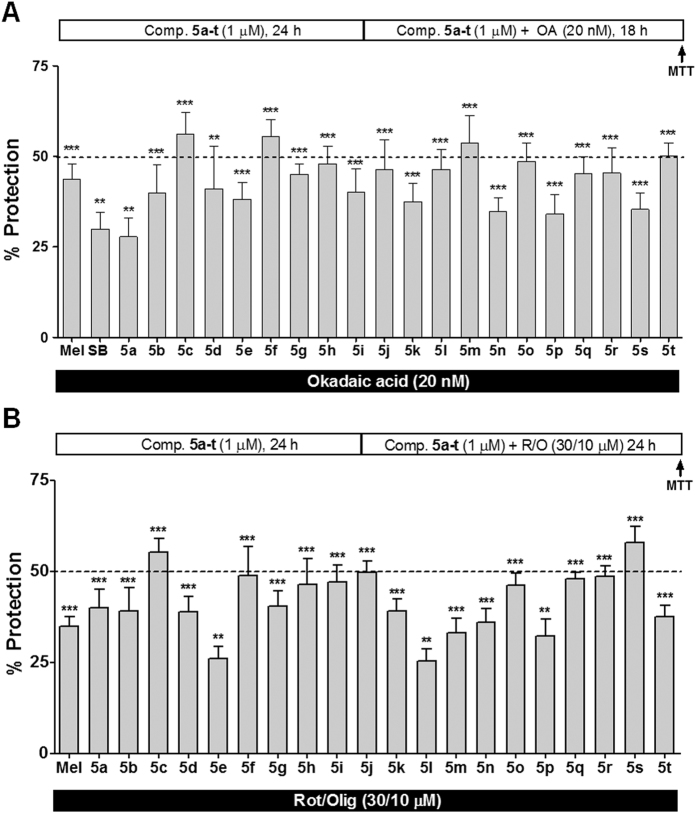
Compounds 5a–t exert neuroprotection in in vitro models of AD.Neuroprotective effect of compounds 5a–t at 1 μM, melatonin (1 μM) and SB216763 (1 μM) against toxicity elicited by tau hyperphosphorylation (A, OA, 20 nM) or oxidative stress and energy depletion (B, R/O, 30/10 μM). SH-SY5Y cells were pre-incubated for 24 h with compounds 5a–t, melatonin or SB216763 at 1 μM. Then, treatments were removed and cells were co-incubated with each treatment and okadaic acid for 18 h or R/O for 24 h. Cell viability was measured by the MTT reduction assay. Values are expressed as mean ± SEM of five independent experiments in triplicate. ***p < 0.001; **p < 0.01 respect to toxic stimuli treated cells, considered as 0% of protection.